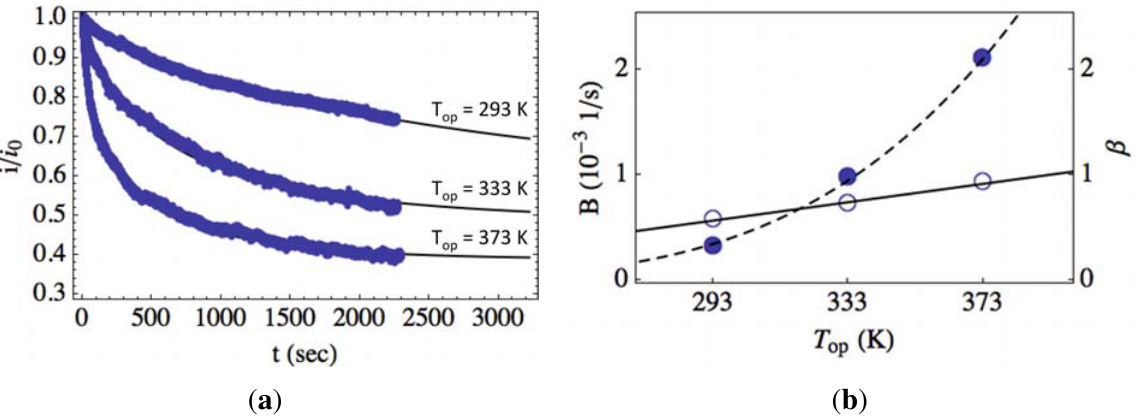
Figure 7. ( a ) Photocurrent transient relaxation with increasing temperature measured at 293, 333 and 373 K (solid circles) for intensity P = 0.2 mW/cm 2 . Experimental data is fit to Equation (11), with the best fits shown as the solid lines. For T ( b ) The fitting parameters, B (filled circles) and β (hollow circles), are plotted as a function of temperature and fit to an Arrhenius (dashed line) and linear (solid line) model,